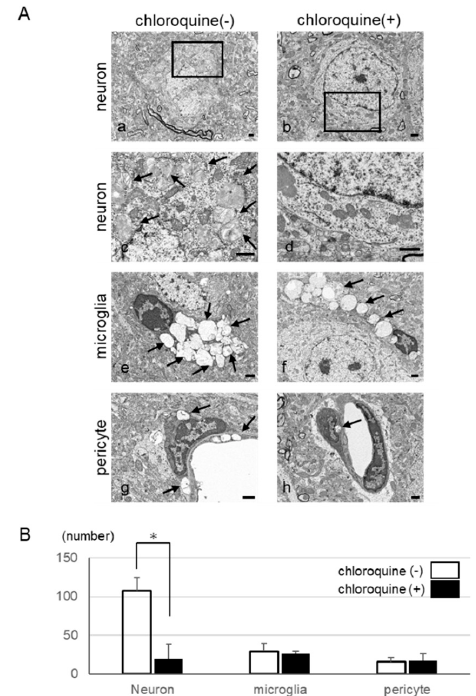
Figure 7. Therapeutic effect of orally administered chloroquine in the cerebral cortex. ( A) Electron micrographs of the cerebral cortex with or without chloroquine treatment: Representative images of neurons (a and c), microglia (e), and pericytes (g) in the cerebral cortex of untreated mice. Representative images of neurons (b and d), microglia (f), and pericytes (h) in the cerebral cortex of treated mice. Fewer cytoplasmic vacuoles (arrows) were seen in the neurons after chloroquine treatment than in the untreated group. Panels c and d show magnified views of areas indicated by black rectangles in a and b, respectively. Bar = 1 μ m. ( B ) Changes in the number of cells with vacuoles in the cytoplasm with and without the oral administration of chloroquine. The number of neurons showing vacuolation was markedly decreased after the oral administration of chloroquine. However, the number of microglia and pericytes did not change. * p < 0.05.